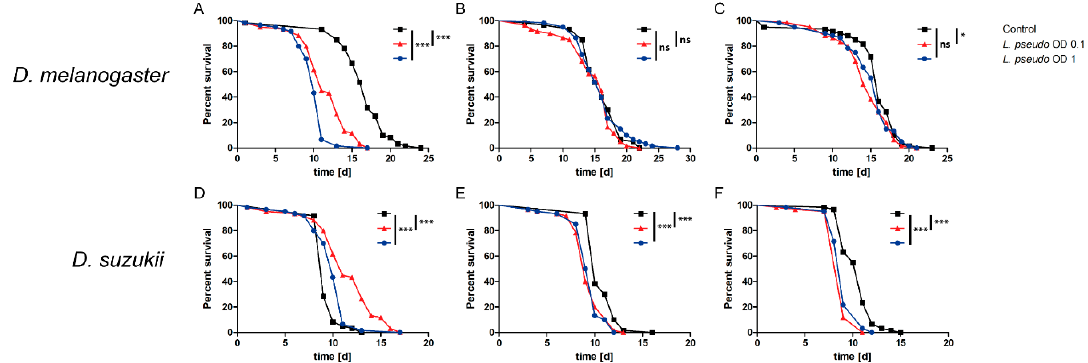
Figure 2. Survival curves for the septic infection of Drosophila melanogaster and D. suzukii with Leuconostoc pseudomesenteroides . Adult flies (3–10 days old) were injected with 4.6 nL of L. pseudomesenteroides suspension (OD 600 = 1 or 0.1) or a PBS control. Each survival assay was carried out three times (biological replicates) with three technical replicates (n = 540). A logrank test was used for statistical analysis. ( A – C ) All three biological replicates of survival assays with D. melanogaster . ( D – F ) All three biological replicates of survival assays with D. suzukii . Statistical significance is indicated as follows: p ≤ 0.0009 ***; p ≤ 0.009 **; p ≤ 0.09 *; ns, not significant.